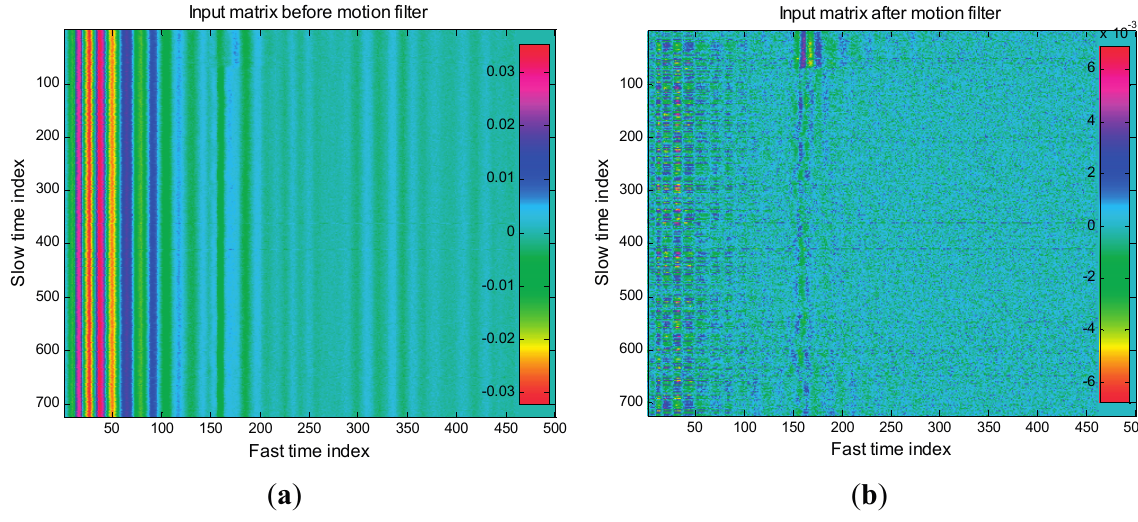
Figure 19. Experimental data. ( a ) Before motion filtering; ( b ) After motion